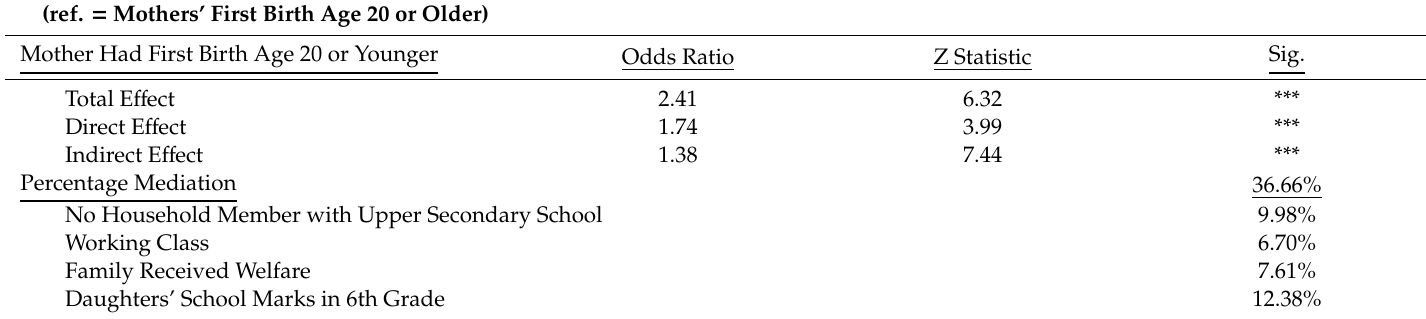
Table 3. Logit Models Decomposing (with KHB) Total E ff ects of Mothers’ Early Childbearing on Daughters’ Early Childbearing via Socioeconomic Characteristics and Daughters’ School Performance ( N =